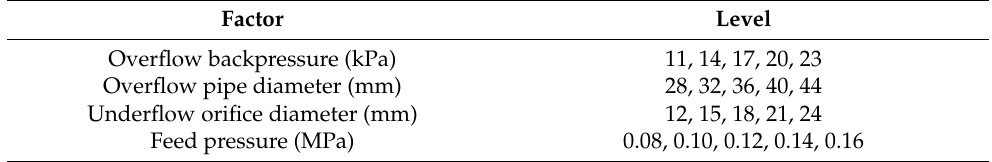
Table 2. Test parameters. Factor